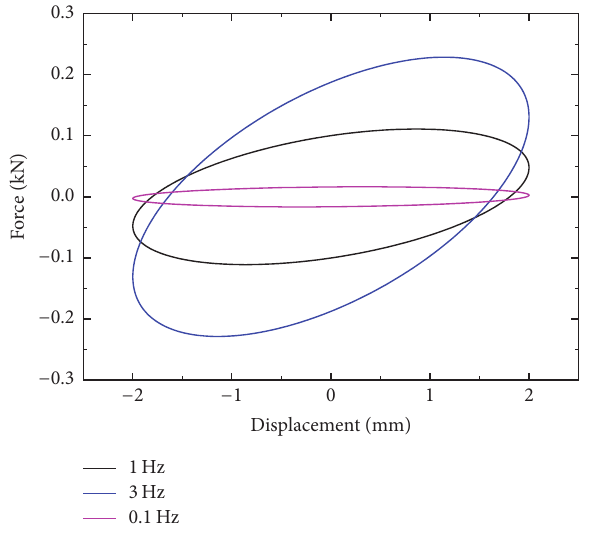
Figure 3: The force-displacement loop of